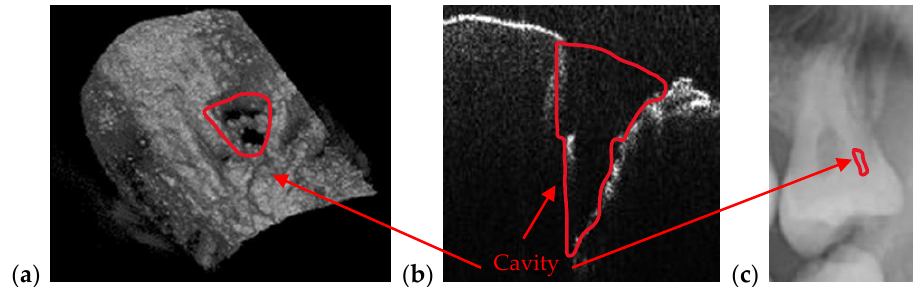
Figure 9. Cavity of a third molar from the second quadrant assessed on: ( a ) an OCT 3D reconstruction and ( b ) an OCT B-scan, both performed on the tooth extracted for medical purposes after performing the radiography; ( c ) a section cropped from a panoramic radiograph. Patient C.M., male, age 24 years, diagnosed with a small cavity, with the following remarks on his clinic condition: the tooth did not pass completely from the gingiva, but food, as well as degenerative factors entered between tooth and gingiva. This is the reason the cavity has appeared.